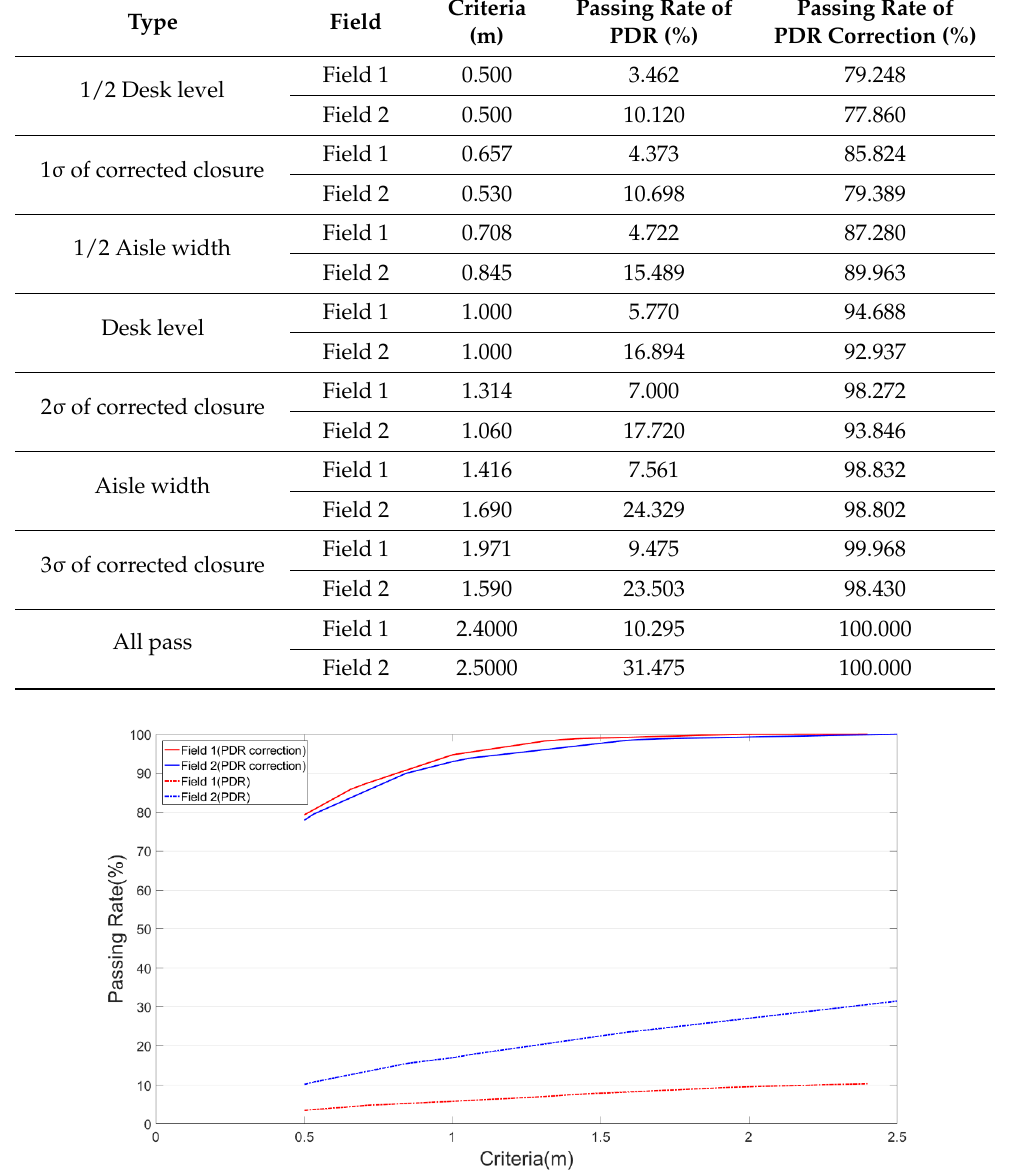
Table 6. Results of cumulative passing rate.